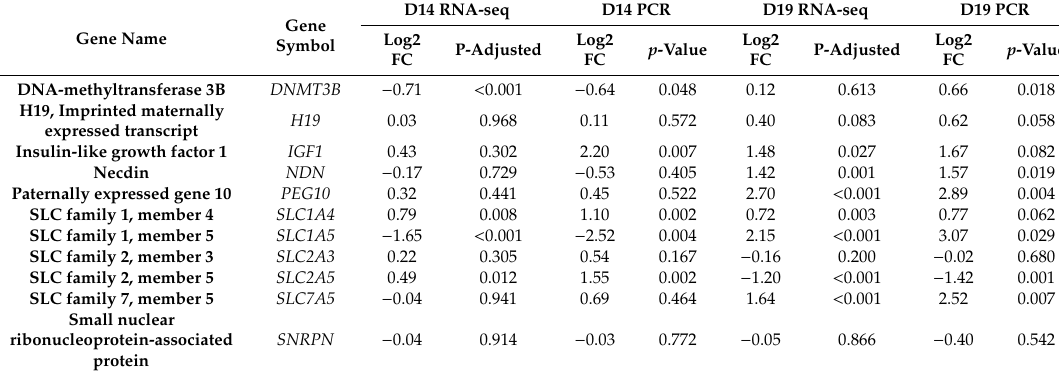
Table 3. Validation of the RNA-seq results by qRT-PCR for selected genes in equine conceptus membranes 6 (day 14) and 11 (day 19) days after transfer of day 8 embryos to the uterus of mares on day 8 (synchronous) or day 3 (asynchronous) after ovulation. Day 14 synchronous vs. asynchronous and day 19 synchronous vs. asynchronous. Positive values represent upregulated genes, and negative values represent downregulated genes in synchronous pregnancies. Solute carrier: SLC; fold change: